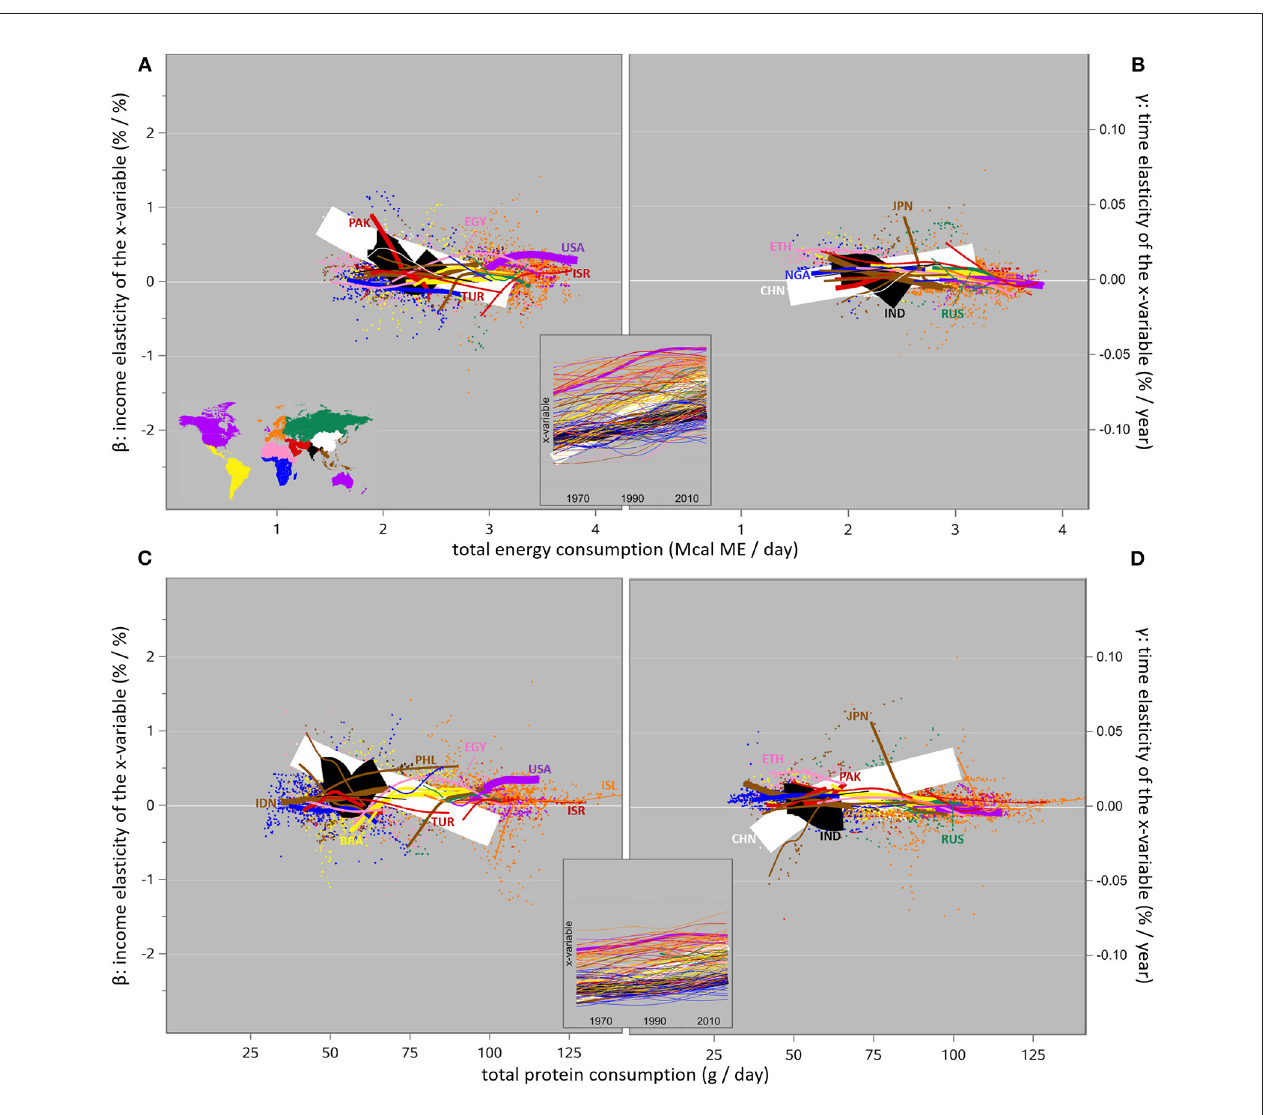
FIGURE 6 | Regression coefficients of the logarithm of total daily energy (A,B) or protein (C,D) consumption on the logarithm of annual income ( β : the income elasticity , adjusted for time-related non-income effects), and on time and its associated non-income effects ( γ : the time elasticity , adjusted for income effects), from 1961 to 2017. Both estimates change over time and are shown in relation to each year’s actual consumption on the x-axes. Each datapoint represents a country-year combination. The trendlines are spline interpolation plots (see Figure 3 for details) across time for the most populous countries, and for the countries with the highest consumption levels, covering > 76% of the world population. The insets show the time trends of consumption (i.e. the x-variables of the main graphs), as in Figure 3B . The width of each trendline reflects the country’s population size in